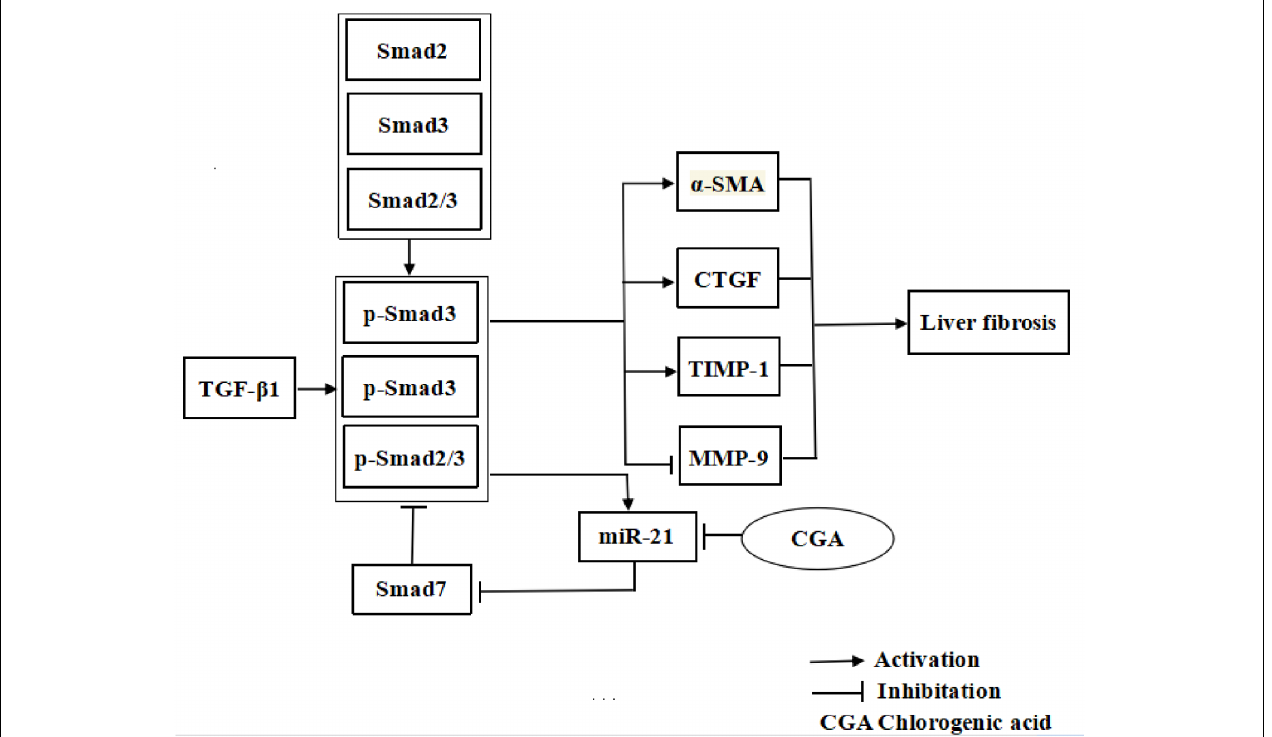
FIGURE 11 | The illustration of CGA protecting against liver fibrosis in vitro and in vivo by regulating miR-21-regulated TGF- β 1/Smad7 signaling pathway.